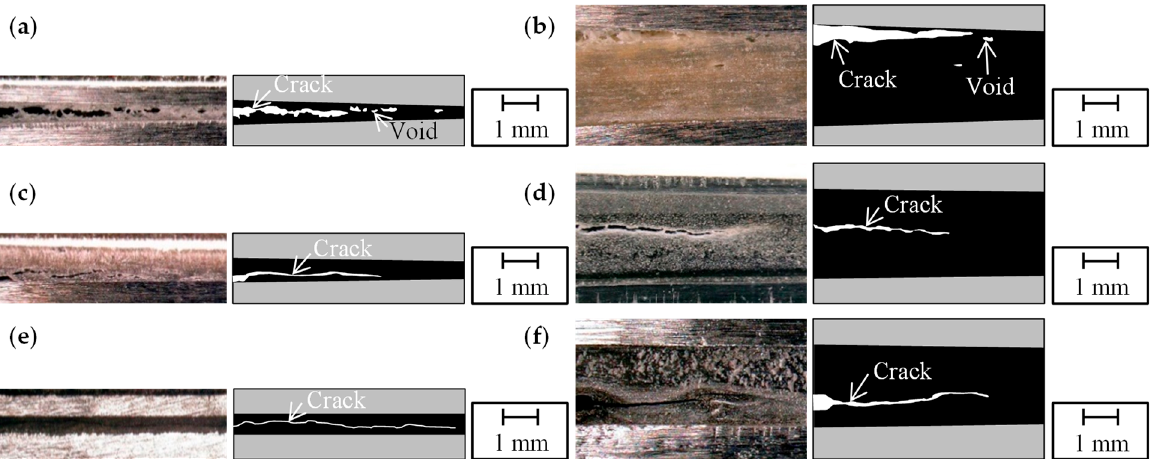
Figure 7. Observation results from the side of DCB specimen before resuming the test of ( a ) 0.3 mm thickness of Y618H, ( b ) 3.0 mm thickness of Y618H, ( c ) 0.3 mm thickness of Metal Lock, ( d ) 3.0 mm thickness of Metal Lock, ( e ) 0.3 mm thickness of Y611 Black S, and ( f ) 3.0 mm thickness of Y611 Black S.